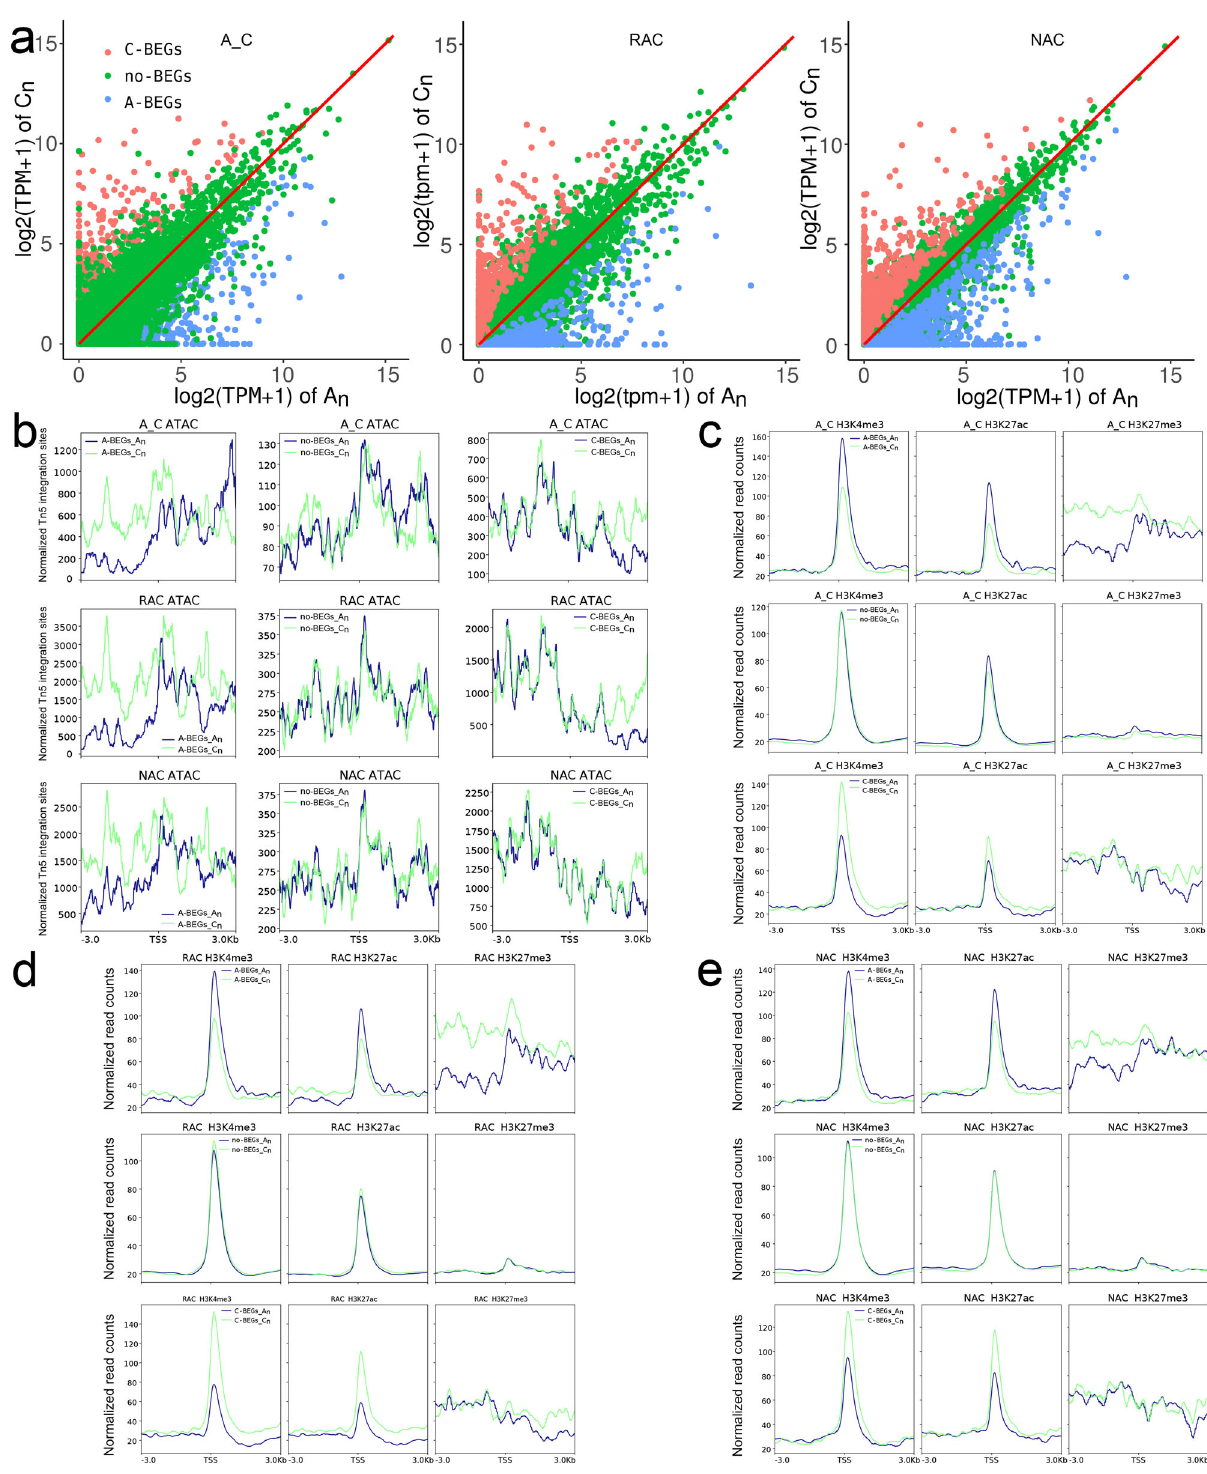
Fig. 9 Comparison of gene expression levels and fi ve epigenetic modi fi cations between homeologous gene pairs. a The distribution of gene expression levels of homeologous gene pairs. b Chromatin accessibility of homeologous gene pairs. c H3K4me3, H3K27ac and H3K27me3 levels of homeologous gene pairs in A_C. d H3K4me3, H3K27ac and H3K27me3 levels of homeologous gene pairs in RAC. e H3K4me3, H3K27ac and H3K27me3 levels of homeologous gene pairs in NAC. A_C, in silico ‘ hybrid ’ ; RAC, resynthesized B. napus ; NAC, natural B. napus ; TSS, transcriptional start chromatin accessibility on gene expression, and accessible chro- distinct subgenomes, often results in genome-wide expression matin did not necessarily activate transcription. dominance 58 . The phenomenon that unbalanced epigenetic modi fi cations can regulate biased gene expression between formation 44 . The “ genomic shock ” , large-scale con fl ict of subgenomes has been observed in many allopolyploids, such as